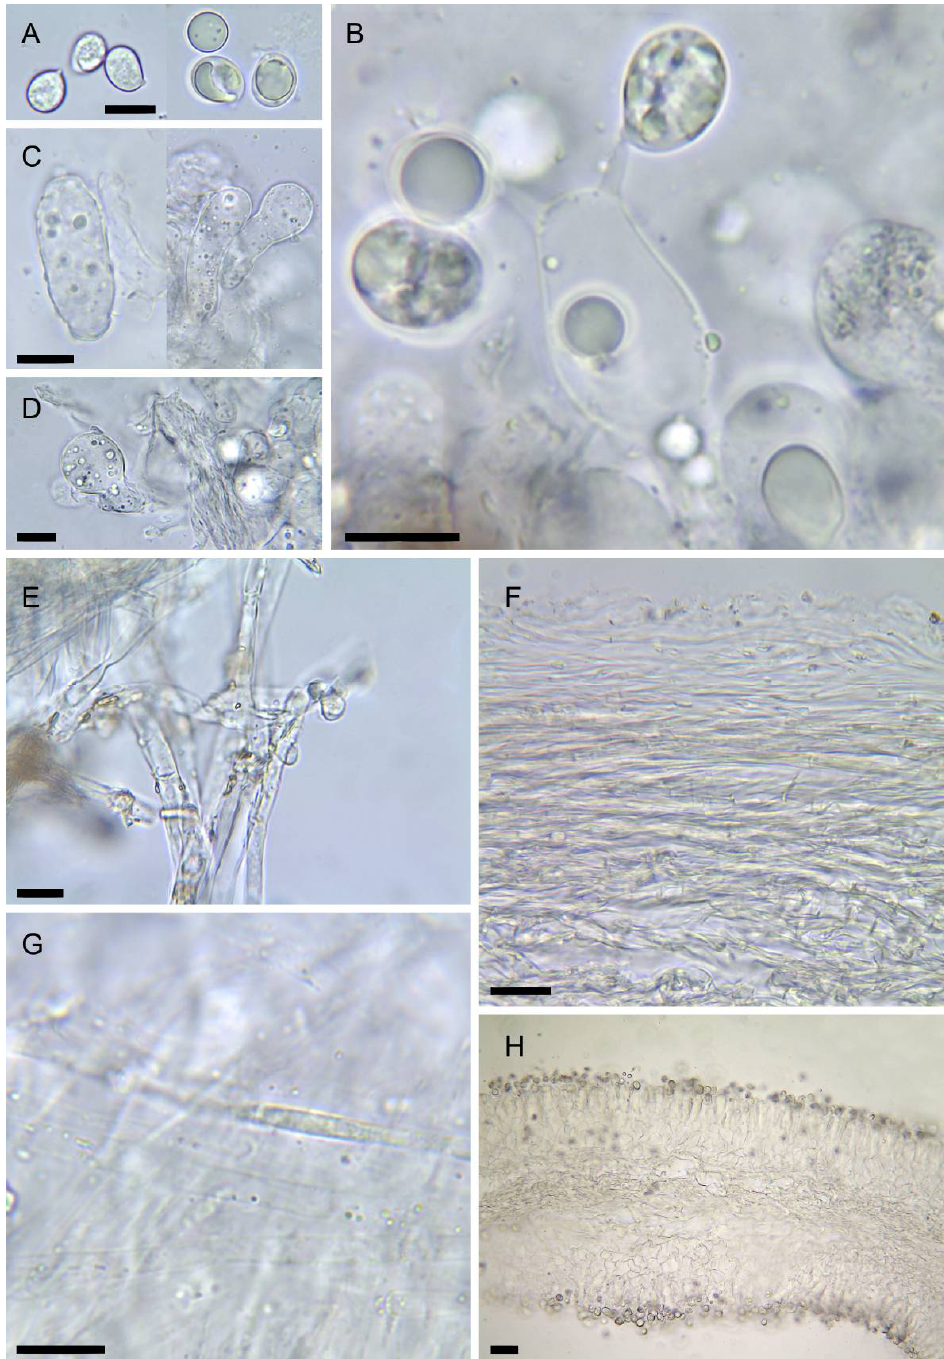
Figure 7. Amanita vidua (LIP:0401591). ( A ) Basidiospores. ( B ) Hymenium. ( C ) Terminal cells on lamella edge. ( D ) Elements of partial veil (upper surface). ( E ) Universal veil, outer surface. ( F ) Elements of suprapellis. ( G ) Pileipellis, radial section. ( H ) Hymenophore, longitudinal section. All observations in 5% KOH solution. Bar = 10 μm.